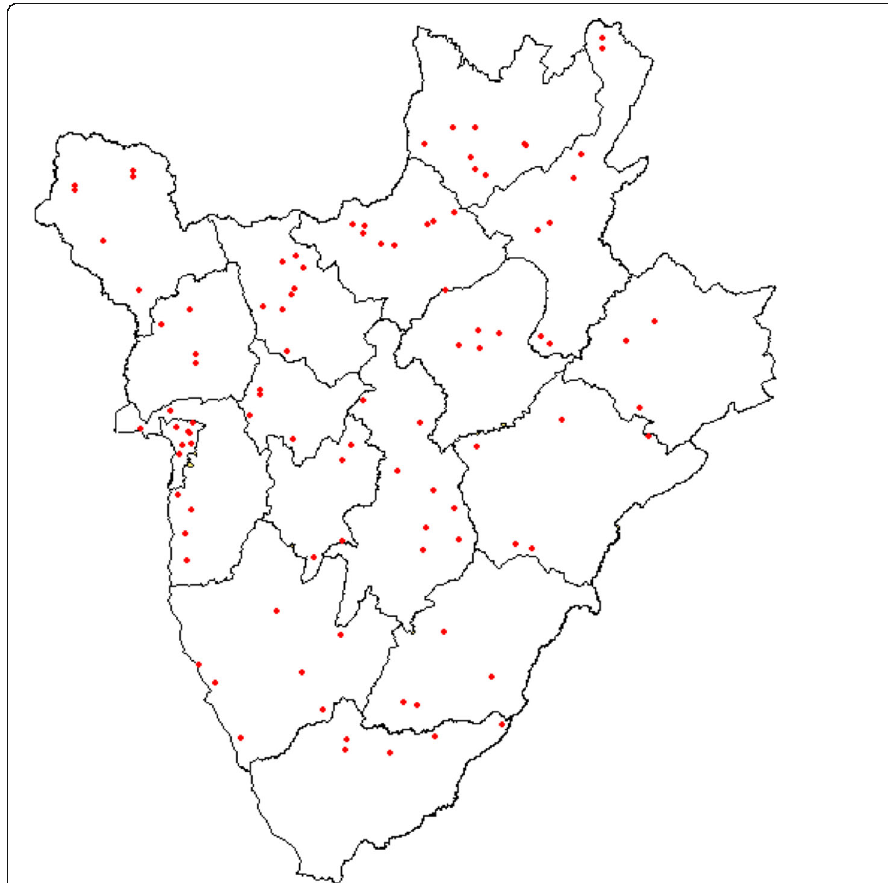
Fig. 2 Location of the communities